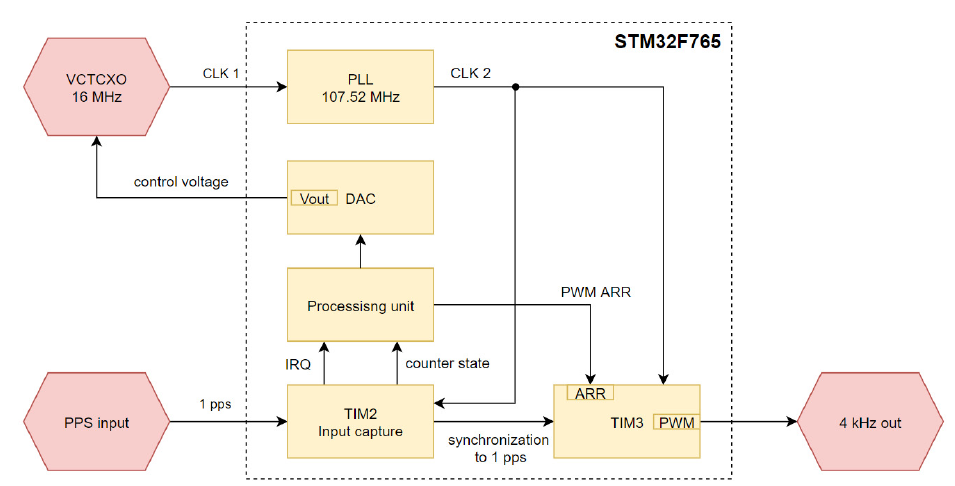
Figure 4. Sampling signal generation implementation in STM32F765 microcontroller.